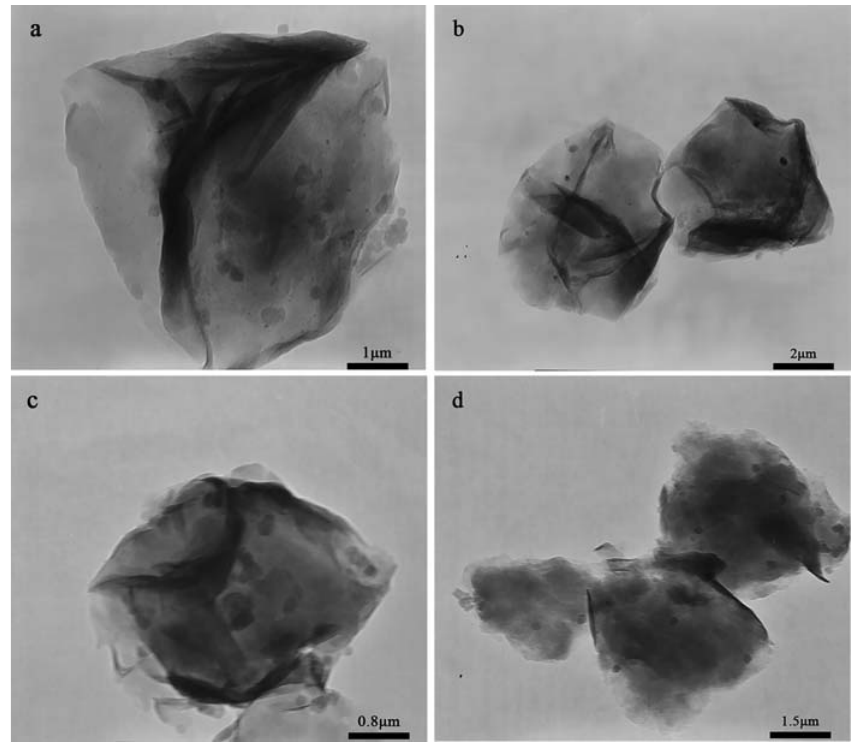
Figure 5: TEM images of MMT and APOP - MMT: ( a and b ) pristine MMT, ( c and d ) APOP -